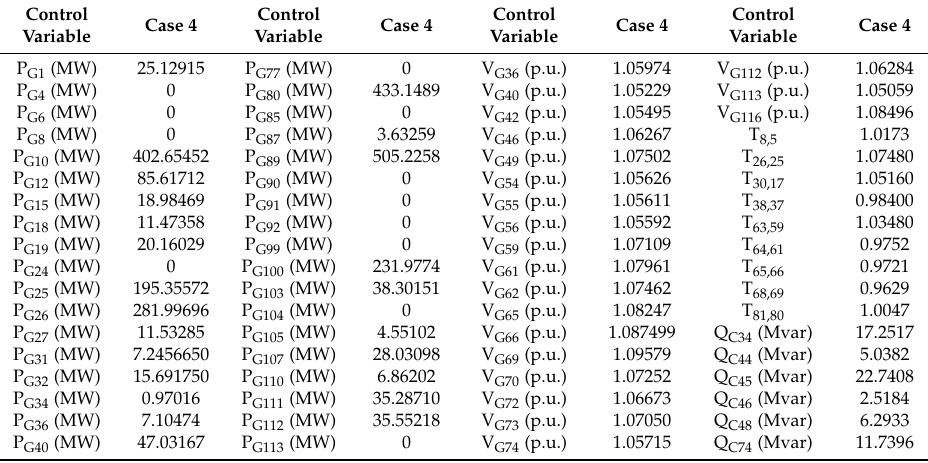
Table 6. Optimum setting of control variables using Jaya algorithm for cost minimization (standard IEEE 118-bus network).